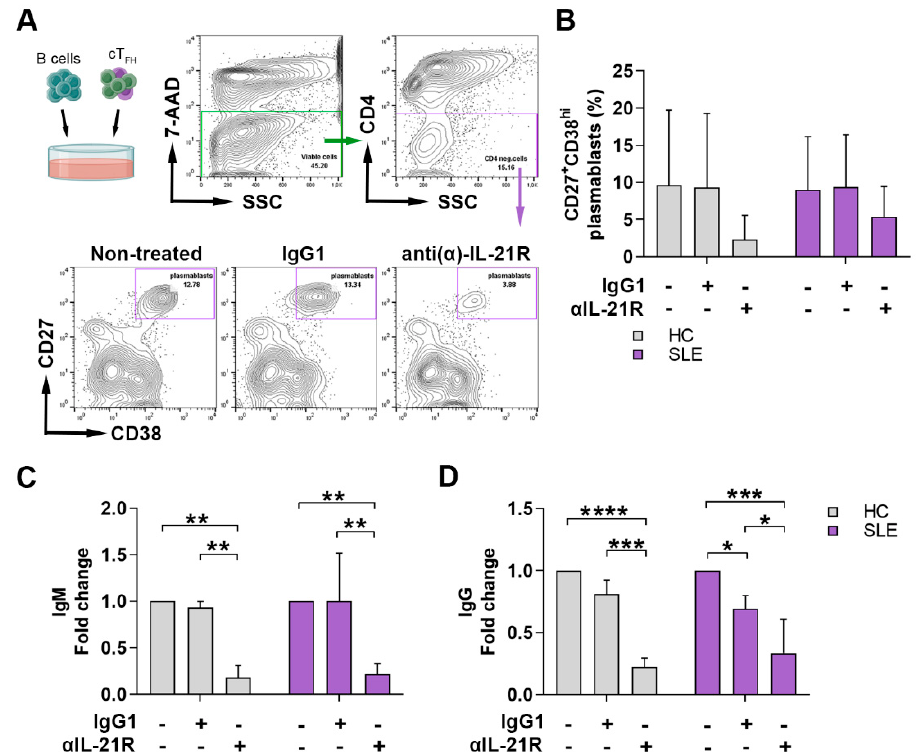
Figure 4. Anti ( α )-IL-21R inhibits T FH cell-dependent B cell differentiation in SLE patients and healthy individuals. ( A ) Representative contour plots show the gating strategy and the blocking of plasmablast differentiation by α IL-21R in SLE. As an isotype control, the IgG1 protein was used. ( B ) Percentages of 7-AAD - CD4 - CD27 + CD38 hi viable plasmablasts were measured by flow cytometry in healthy controls (HC; n = 3) and in SLE patients ( n = 3). Fold change of IgM ( C ) and IgG ( D ) was measured by ELISA in patients with lupus and HC. Bar charts represent mean ± SD. Data analysis was performed with two-way ANOVA followed by Tukey’s multiple comparison tests. Statistically significant differences are defined as * p < 0.05; ** p < 0.01; *** p < 0.001; **** p < 0.0001.